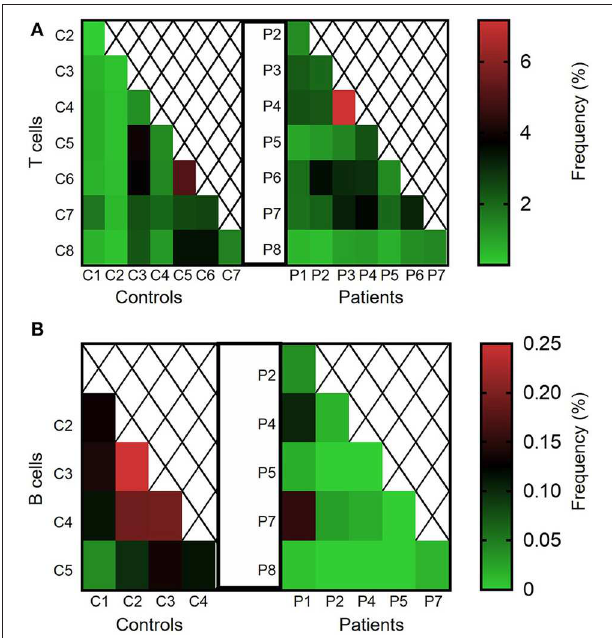
FIGURE 7 | Clonal sharing between controls and between different IL10/IL10R-deficient patients. Degree of clonal sharing is presented in heat maps images, depicting percentage of the (A) TCR and (B) BCR repertoires shared between any two